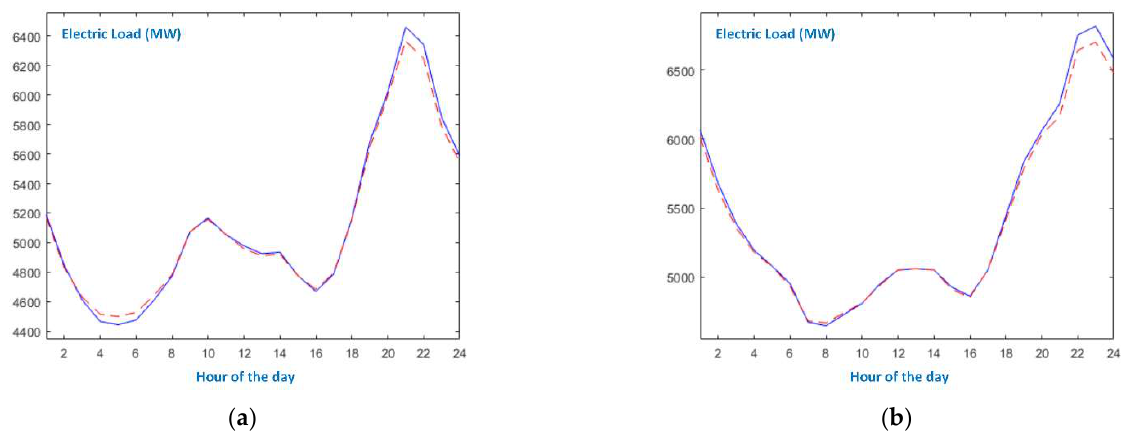
Figure 7. Presentation of summer days. The blue solid line is the actual electric load, and the red dotted line is ReNFuzz-LF’s output: ( a ) working day; ( b ) Sunday.